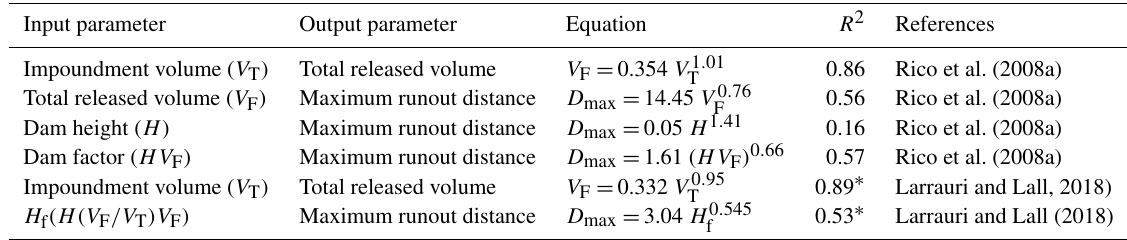
Table 1. Empirical relationships proposed by others for the runout analysis of tailings dam breaches.